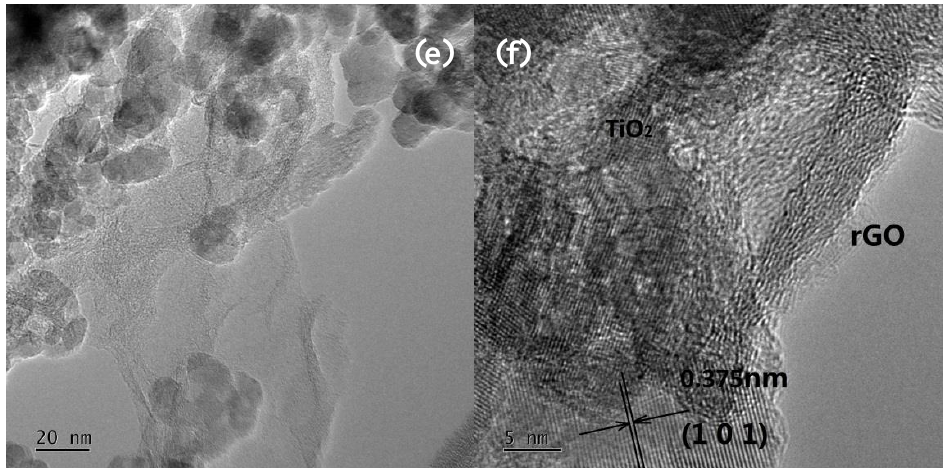
Figure 3. Transmission electron microscopy (TEM) images of GO ( a ), 0.25 g TBT ( c ), and 0.1 g P25 ( e ); High-resolution TEM (HRTEM) images of GO ( b ), 0.25 g TBT ( d ), and 0.1 g P25 ( f ).